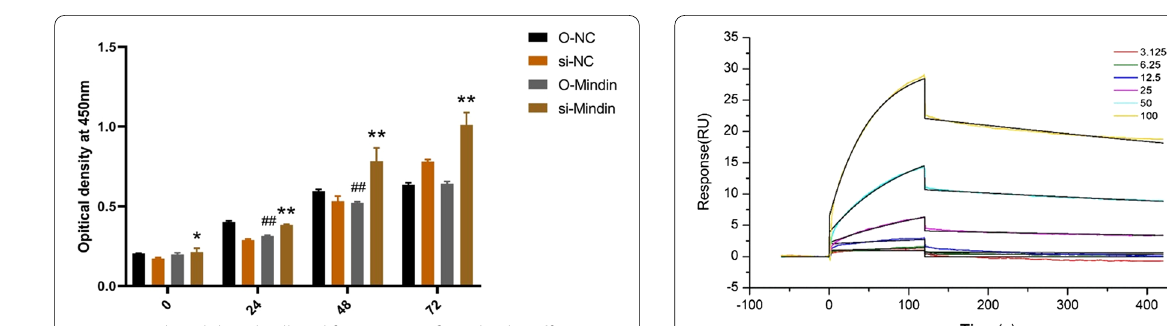
Fig. 7 Mindin inhibited cell proliferation significantly. The effect of Mindin overexpression or knockdown on cell proliferation was